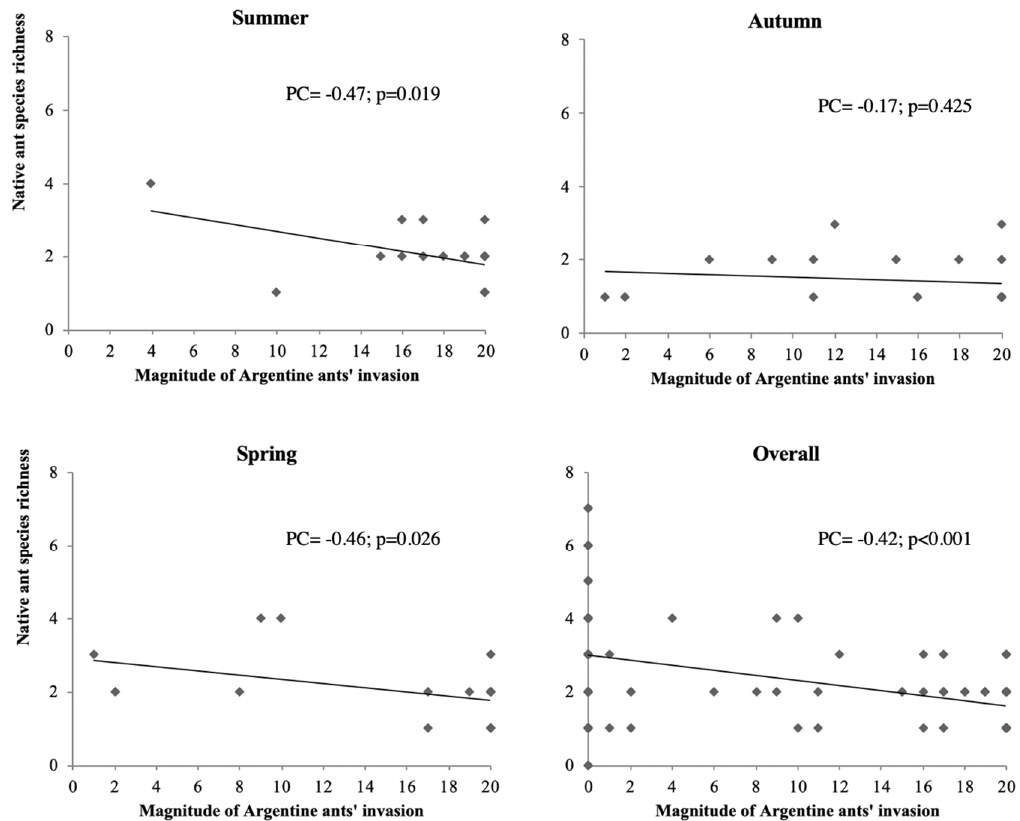
Figure A1. Scatterplot displaying a negative correlation between the magnitude of invasion, i.e., the percentage of infested trees by the Argentine ant, and the number of native ant species per orchard at summer, autumn, spring and overall. Pearson’s Correlation (PC) and p -value are shown.